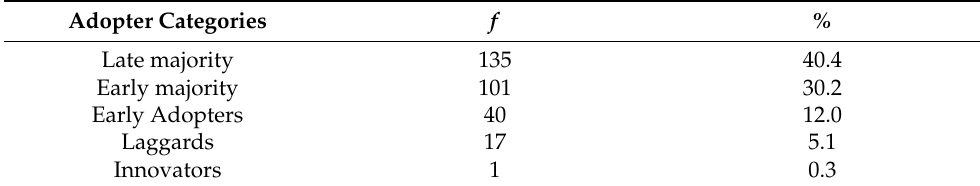
Table 9. Metrics of Agriculturalists’ Adopter Classifications ( n =